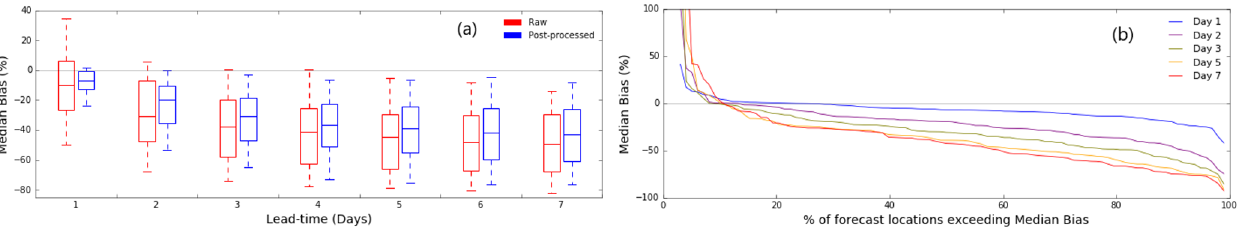
Figure 7. (a) Median bias (%) before (raw) and after streamflow error modelling with ERRIS for the 100 forecast locations, and (b) percent- age of forecast locations exceeding median bias (%) for ERRIS-corrected streamflow forecasts for different lead times.